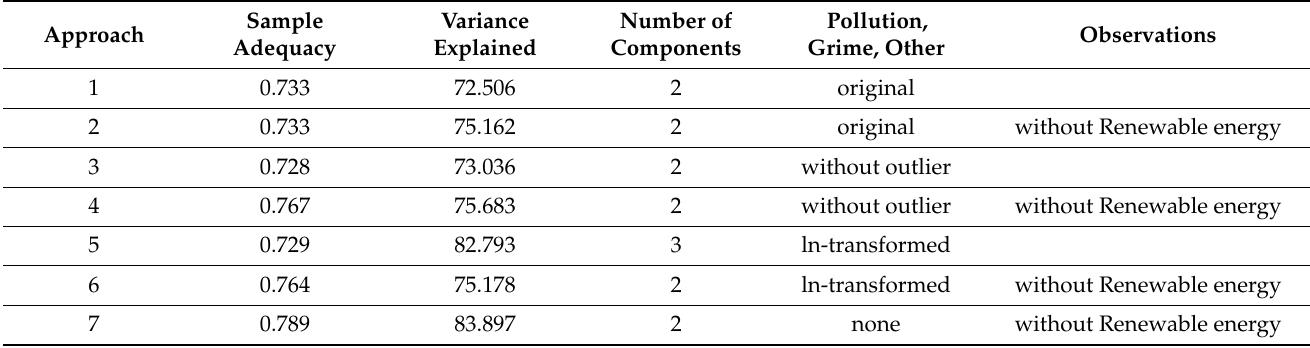
Table 5. Approaches tested for PCA transformation.